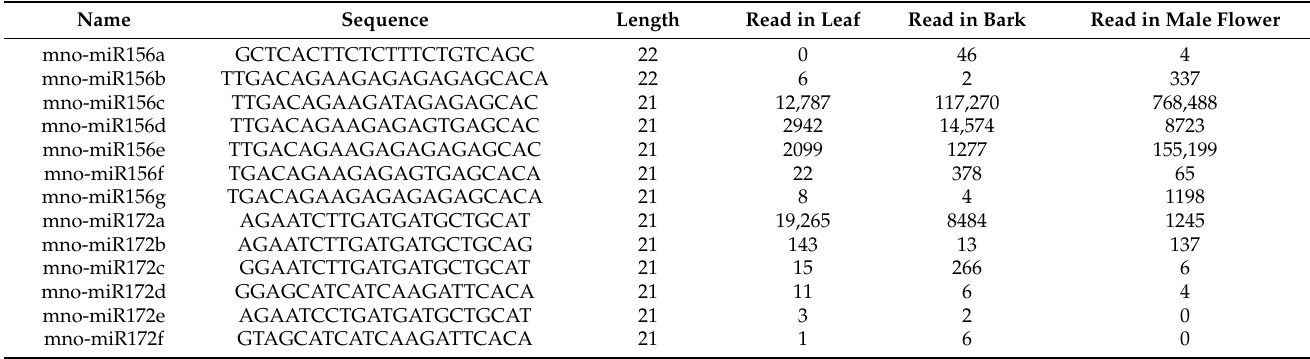
Table 1. miR156 and miR172 in